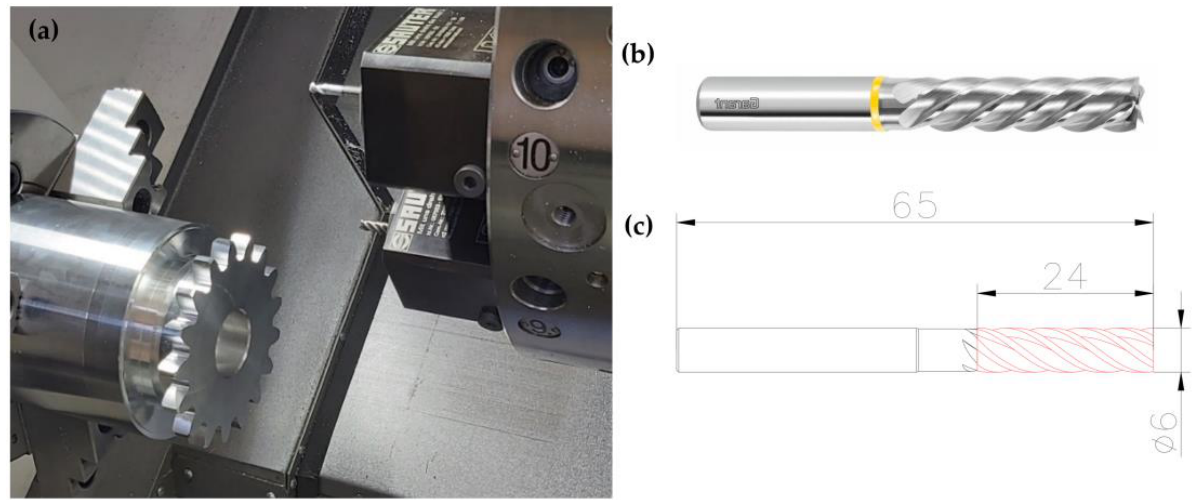
Figure 6. ( a ) The machined gear mounted in a three-jaws chuck. ( b ) The solid carbide cylindrical milling cutter used in processing, ( c ) The dimensions of the milling cutter [29].